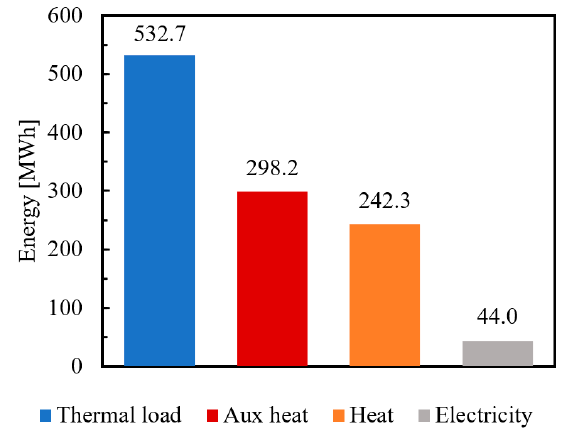
Figure 3. Annual energy yield of the hybrid plant and auxiliary system (Source: Author own calculation).